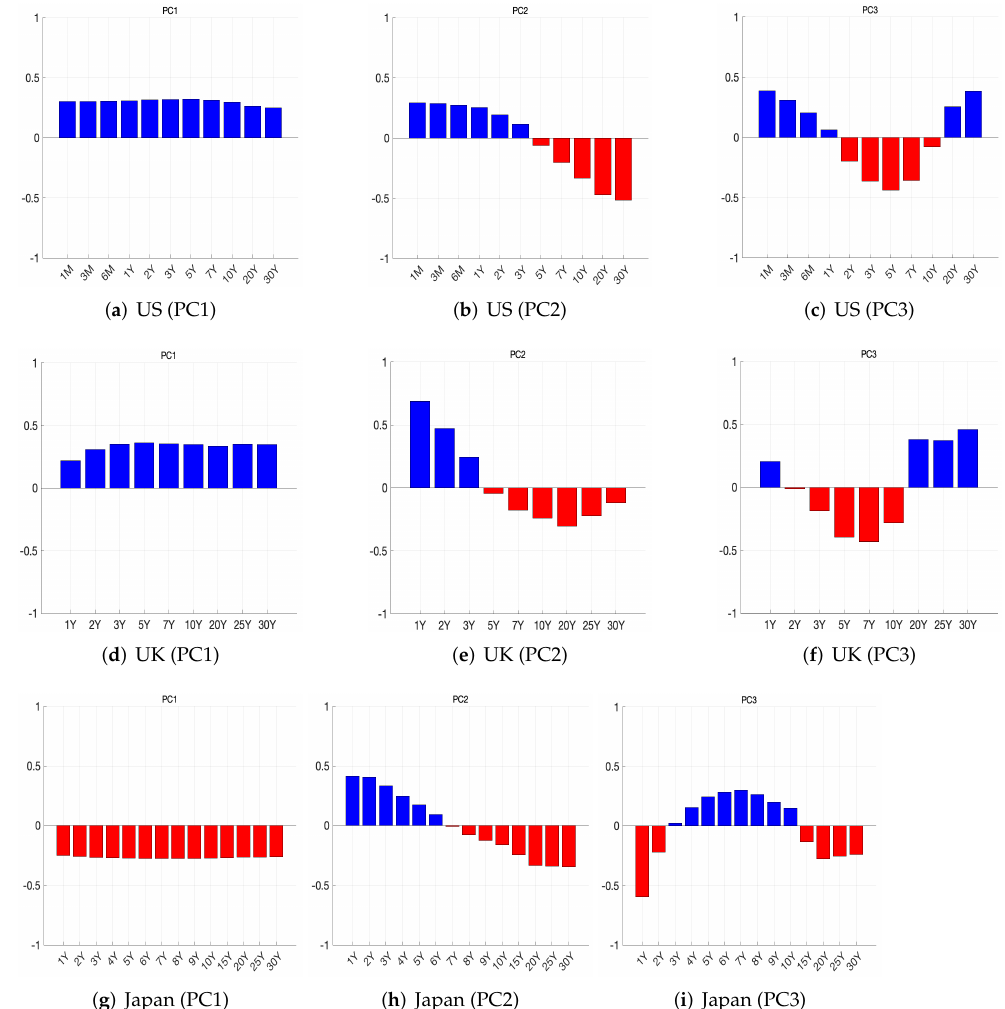
Figure 6. Representation of the first three principal components.